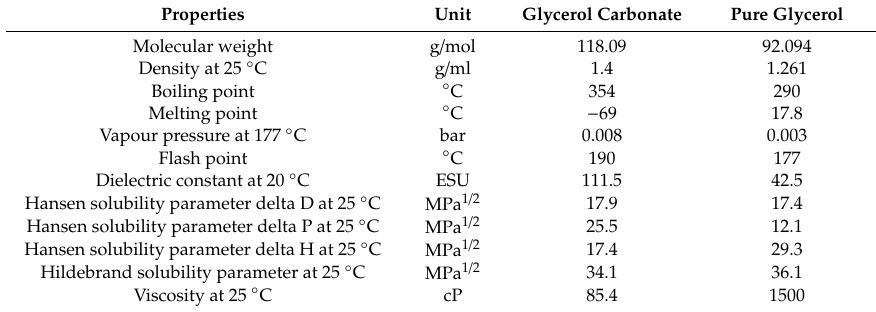
Table 3. The potential application of glycerol carbonate in various industries.